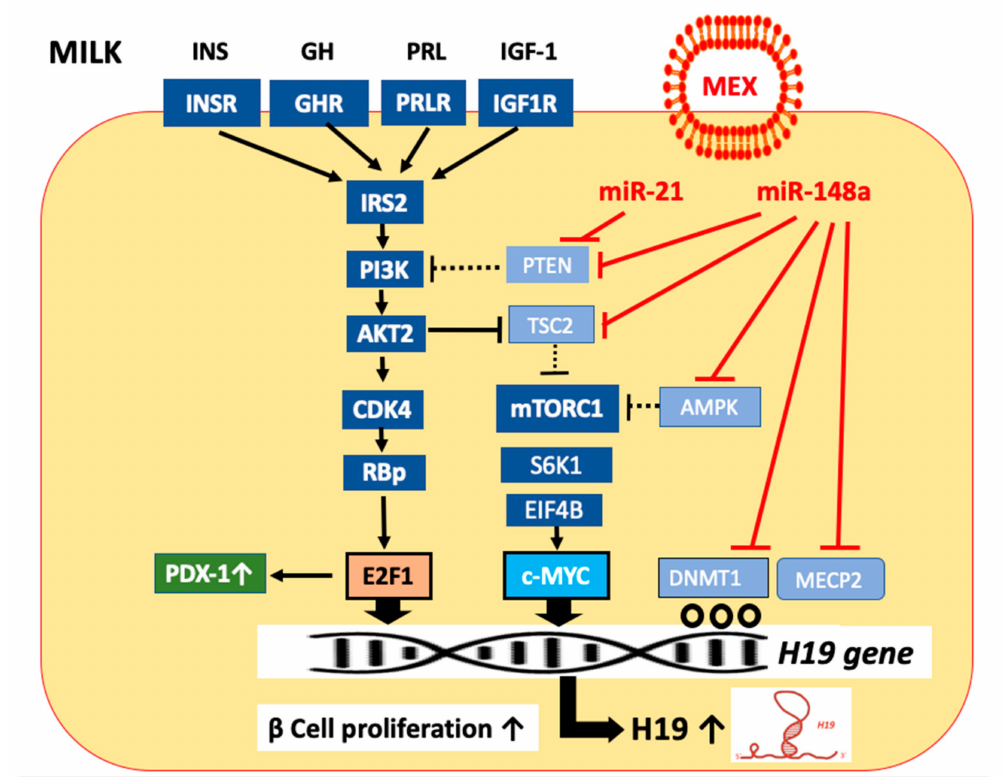
Figure 2. Milk may induce AKT2/mTORC1-mediated β cell proliferation. The growth-promoting hormones of milk, i.e., insulin (INS), growth hormone (GH), prolactin (PRL), and insulin-like growth factor 1 (IGF-1) synergistically activate the kinases AKT and mechanistic target of rapamycin complex 1 (mTORC1). Key exosomal milk (MEX) miRs of human and bovine milk (miR-148a and miR-21) may further augment AKT-mTORC1 signaling by targeting PTEN, TSC2, and AMPK subunits, resulting in increased expression of the proliferative transcription factors E2F1 and c-MYC, respectively. MEX miR-148a-mediated suppression of DNMT1 and MECP2 may decrease H19 promoter methylation, enhancing the transcription of H19 (indicated as open